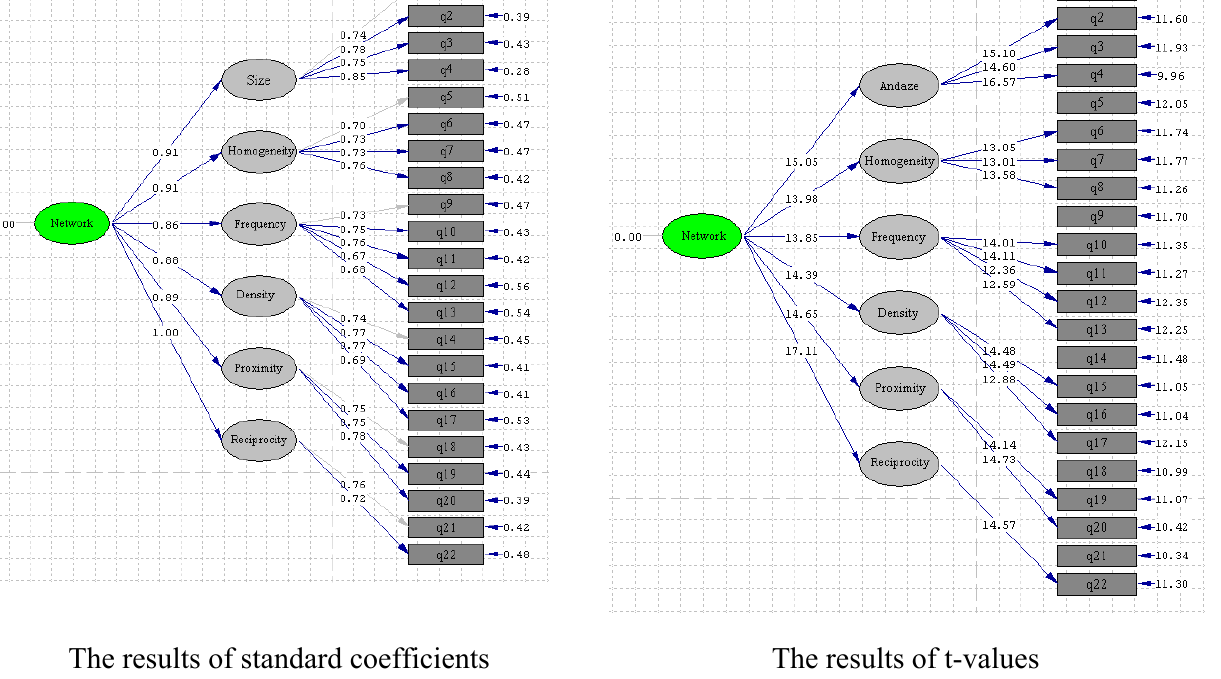
The results of standard coefficients The results of t-values Fig. 3. The results of second order confirmatory factor analysis model for the characteristics of online social